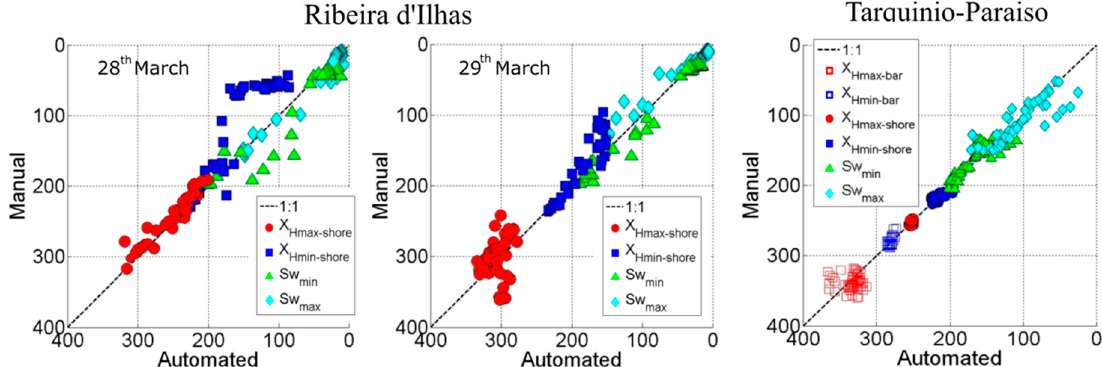
Figure 7. Automated detection performance against manual procedure. x and y axes show distances in m from the landward edge of the profile considered for Timestack production (see also Figures 4 and 5).